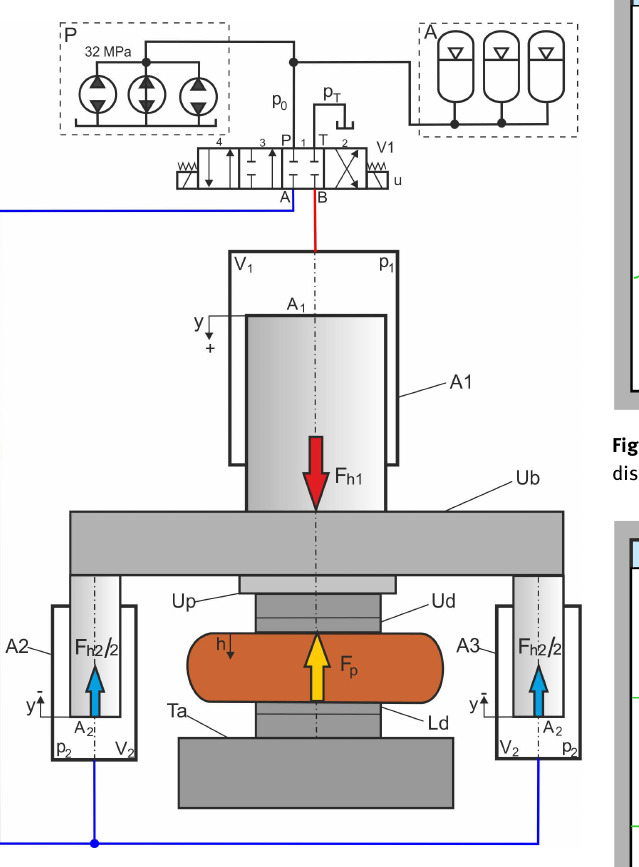
Figure 8: Diagram of a dynamic model of the 80 MN hydraulic press: A1 – main plunger cylinders, A2 – return plunger cylinders, V1 – 4/4/directional control valve, P – water pump station, A – high- pressure water accumulators, Ub – upper beam, Ud – upper die, Ld – lower die, Up – upper plate for fixing the upper die, Ta – table for fixing the lower die